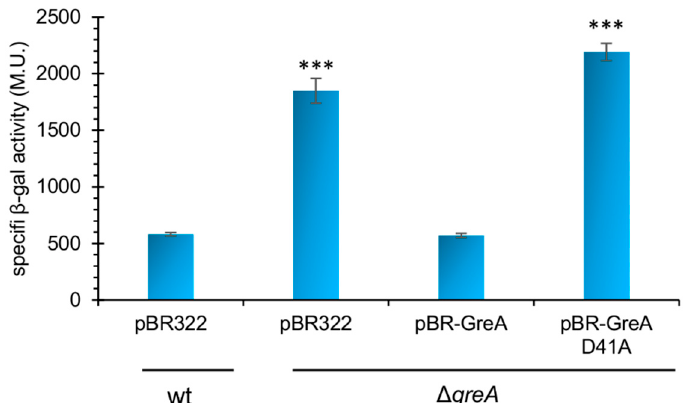
Figure 2. Catalytically active GreA is required for GreA autoregulation. Transcrip tional activity of the greA promoter and leader region ( − 1030 to +175) was measured by monitoring β -galactosiadase activity of the p greA – lacZ fusion in different strain backgrounds: wt — wild type (LFC3 – MG1655 Δ lacZ [17]), Δ greA (LFC4 – MG1655 Δ lacZ Δ greA ); pBR-322 — vector control; pBR – GreA — vector bearing greA gene under its native promoter region (i.e., GraL was present as well); pBR – GreAD41 — the same as pBR-GreA but encoding catalytically inactive GreA. Cells were grown at 37 °C in LB (Luria Broth) with aeration; at OD 600 ~ 1.5 samples were removed and β -galactosidase activity was measured. Average results from three independent experiments are shown. Error bars represent S.D. For clarity, p -values calculated for wt pBR322 vs . Δ greA strains are only shown. *** p < 0.0005.